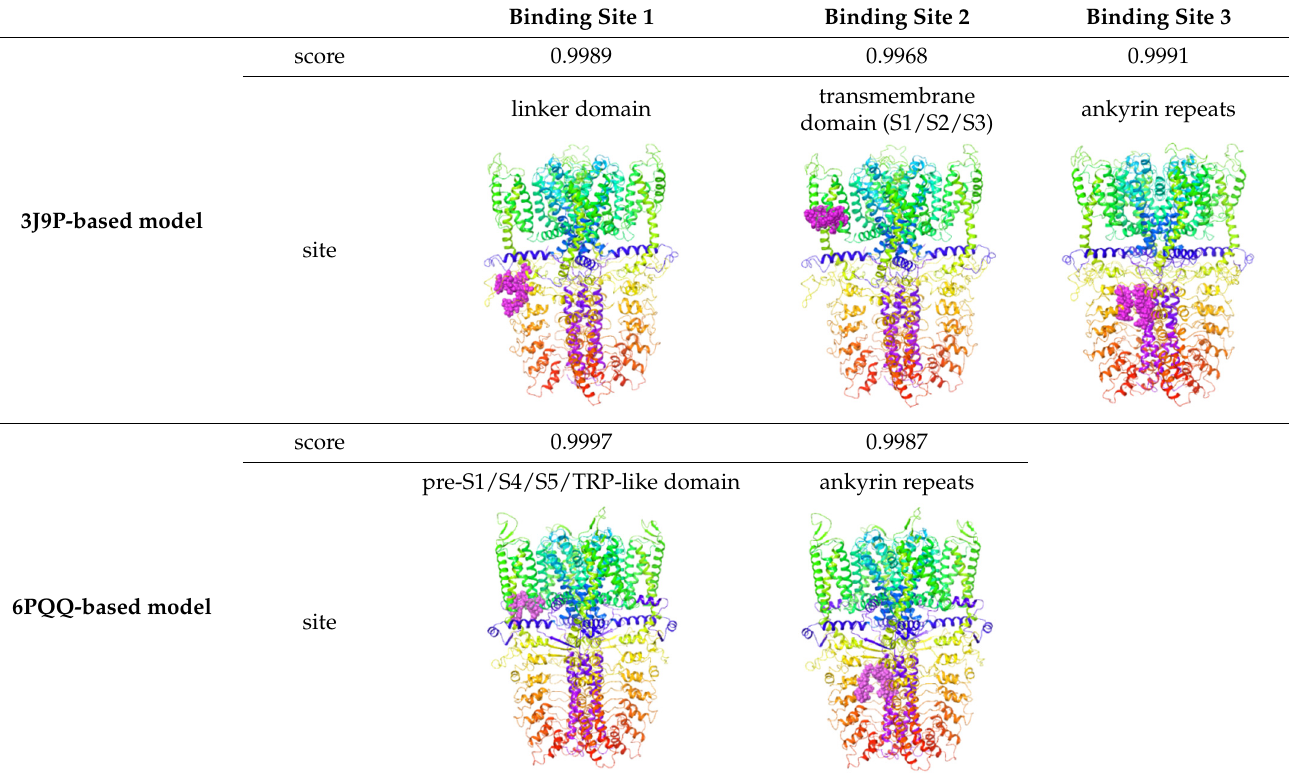
Table 2. Web server Deepsite binding site prediction results for models based on 3J9P and 6PQQ: graphical illustration and evaluation score (the higher the better).